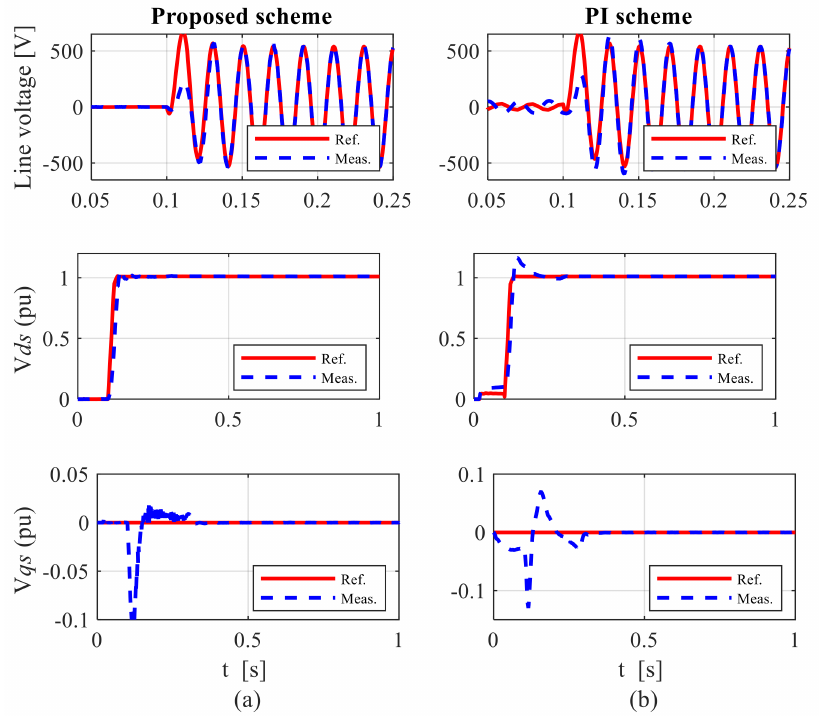
Figure 6. Control performances during sub-synchronous speed operation under balanced grid conditions for R r(perturbed) = 150% R r : ( a ) proposed scheme and ( b ) PI